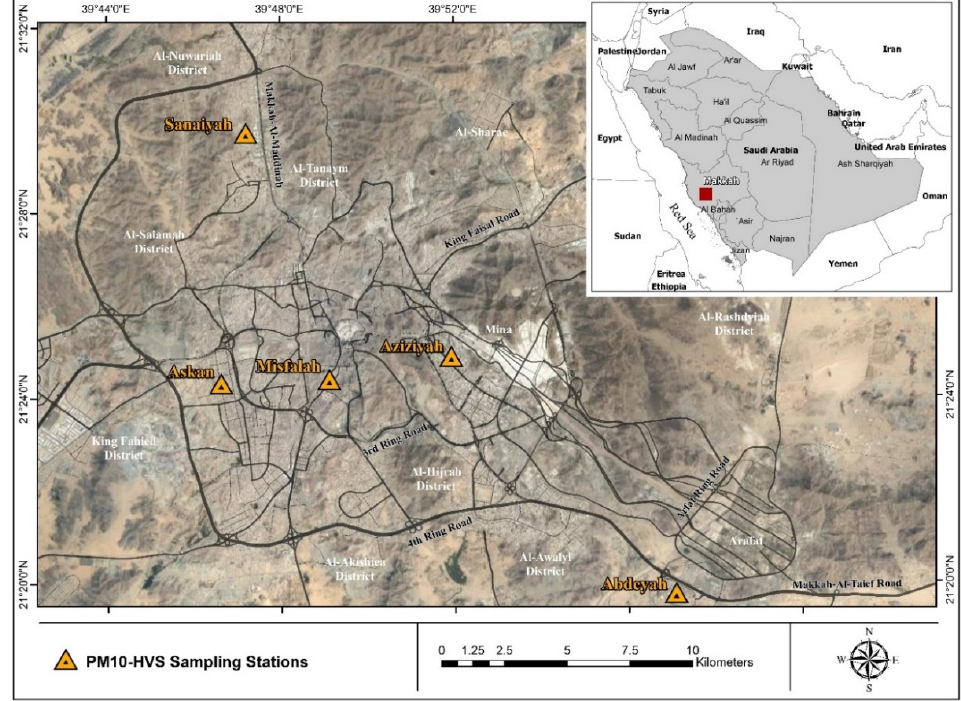
Figure 1. Location map of the sampling stations of PM 10 –HVS in Makkah.